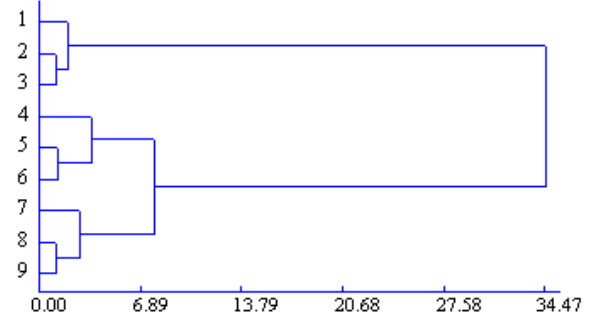
Fig. 2: Dendrogram of the 9 tea samples in different tea plantations by Hierarchical cluster analysis (HCA) according to the 18 free amino acids compositions. The 1, 2 and 3 represent Dahongpao, Shuixian, and Rougui cultivars, respectively in Qishan plantations, 4, 5 and 6 represent Dahongpao, Shuixian, and Rougui cultivars, respectively in Guiyan plantations, and 7, 8 and 9 represent Dahongpao, Shuixian, and Rougui cultivars, respectively in Yu plantations.